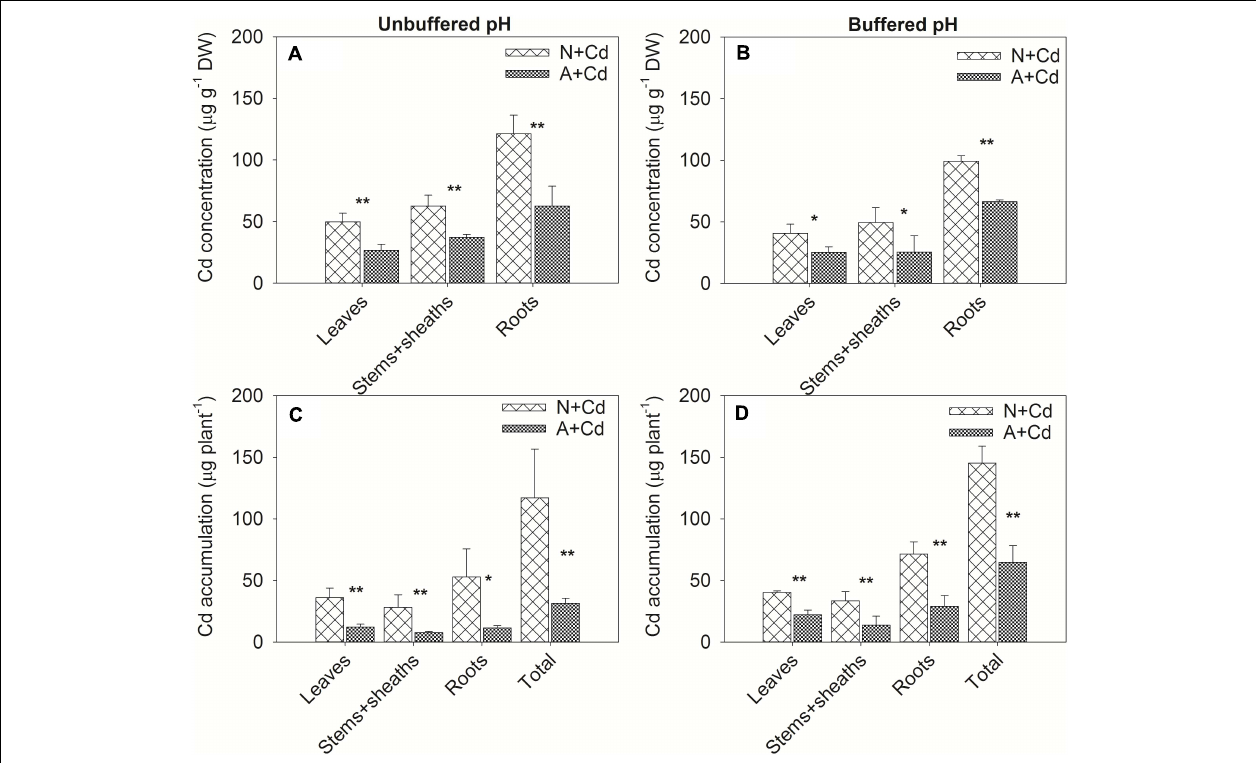
FIGURE 3 | Cd concentrations and accumulation in leaves, stems + sheaths and roots of sweet sorghum as affected by nitrate and ammonium in the presence or absence of Cd under unbuffered (A,C) or buffered (B,D) pH condition. N + Cd, nitrate with Cd; A + Cd, ammonium with Cd. One asterisk “*” indicated significant difference between the two treatments at the level of 0.05 based on student t -test, while two asterisks “**” represented at the level of